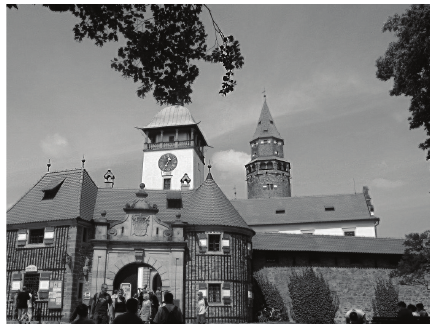
Figure 6: Table—the CA fusion of the image “Castle, ” 4 input images, approximate run time: 359 sec.